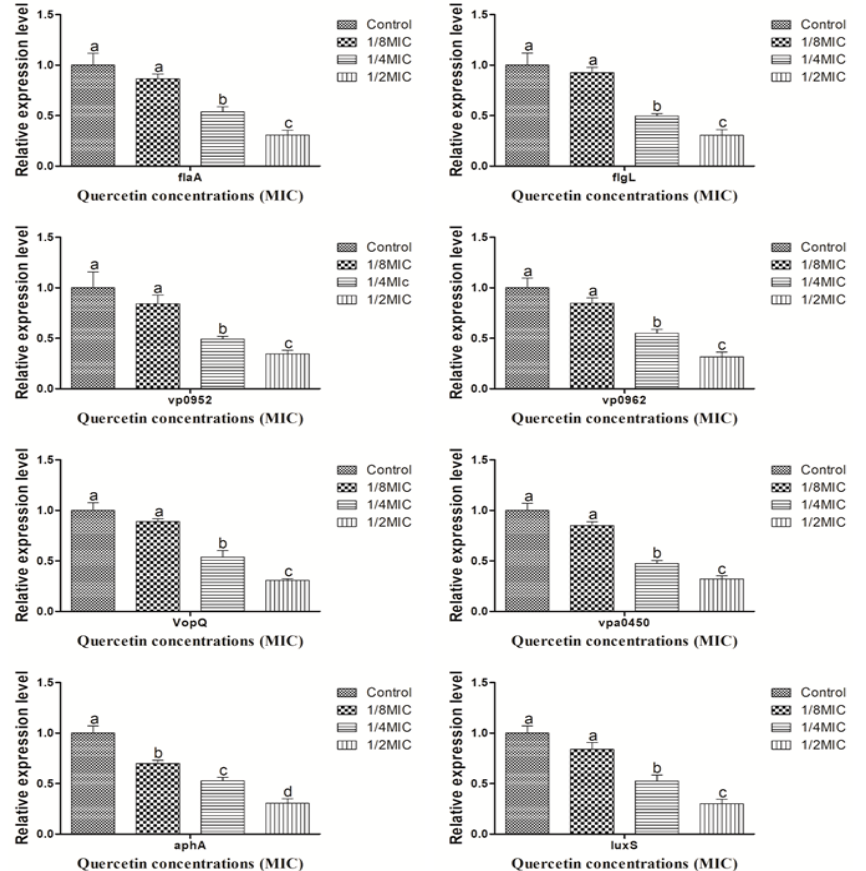
Figure 7. Relative expression levels of flaA , flgL , vp0952 , vp0962 , VopQ , vpa0450 , aphA , and luxS genes indicate significant differences ( p < 0.05) with three independent